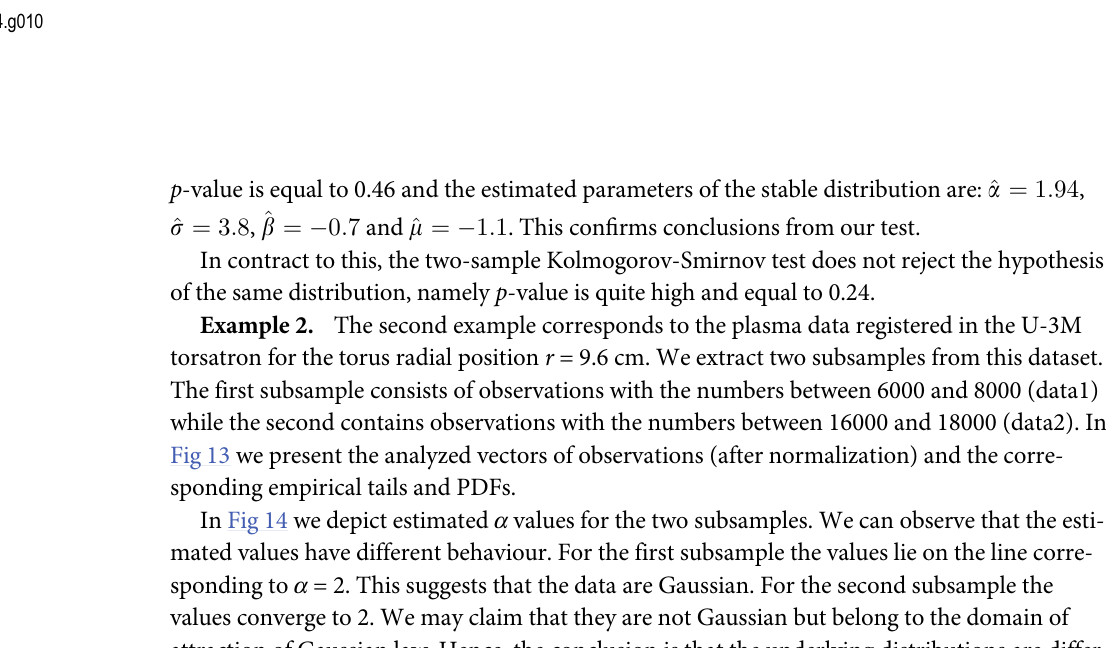
Fig 10. Estimated α values for the stable sample from the top left panel of Fig 9 (top panel) and for the stable sample from the top right panel of Fig 9 (bottom panel). The box plots were constructed from 100 bootstrap samples of length